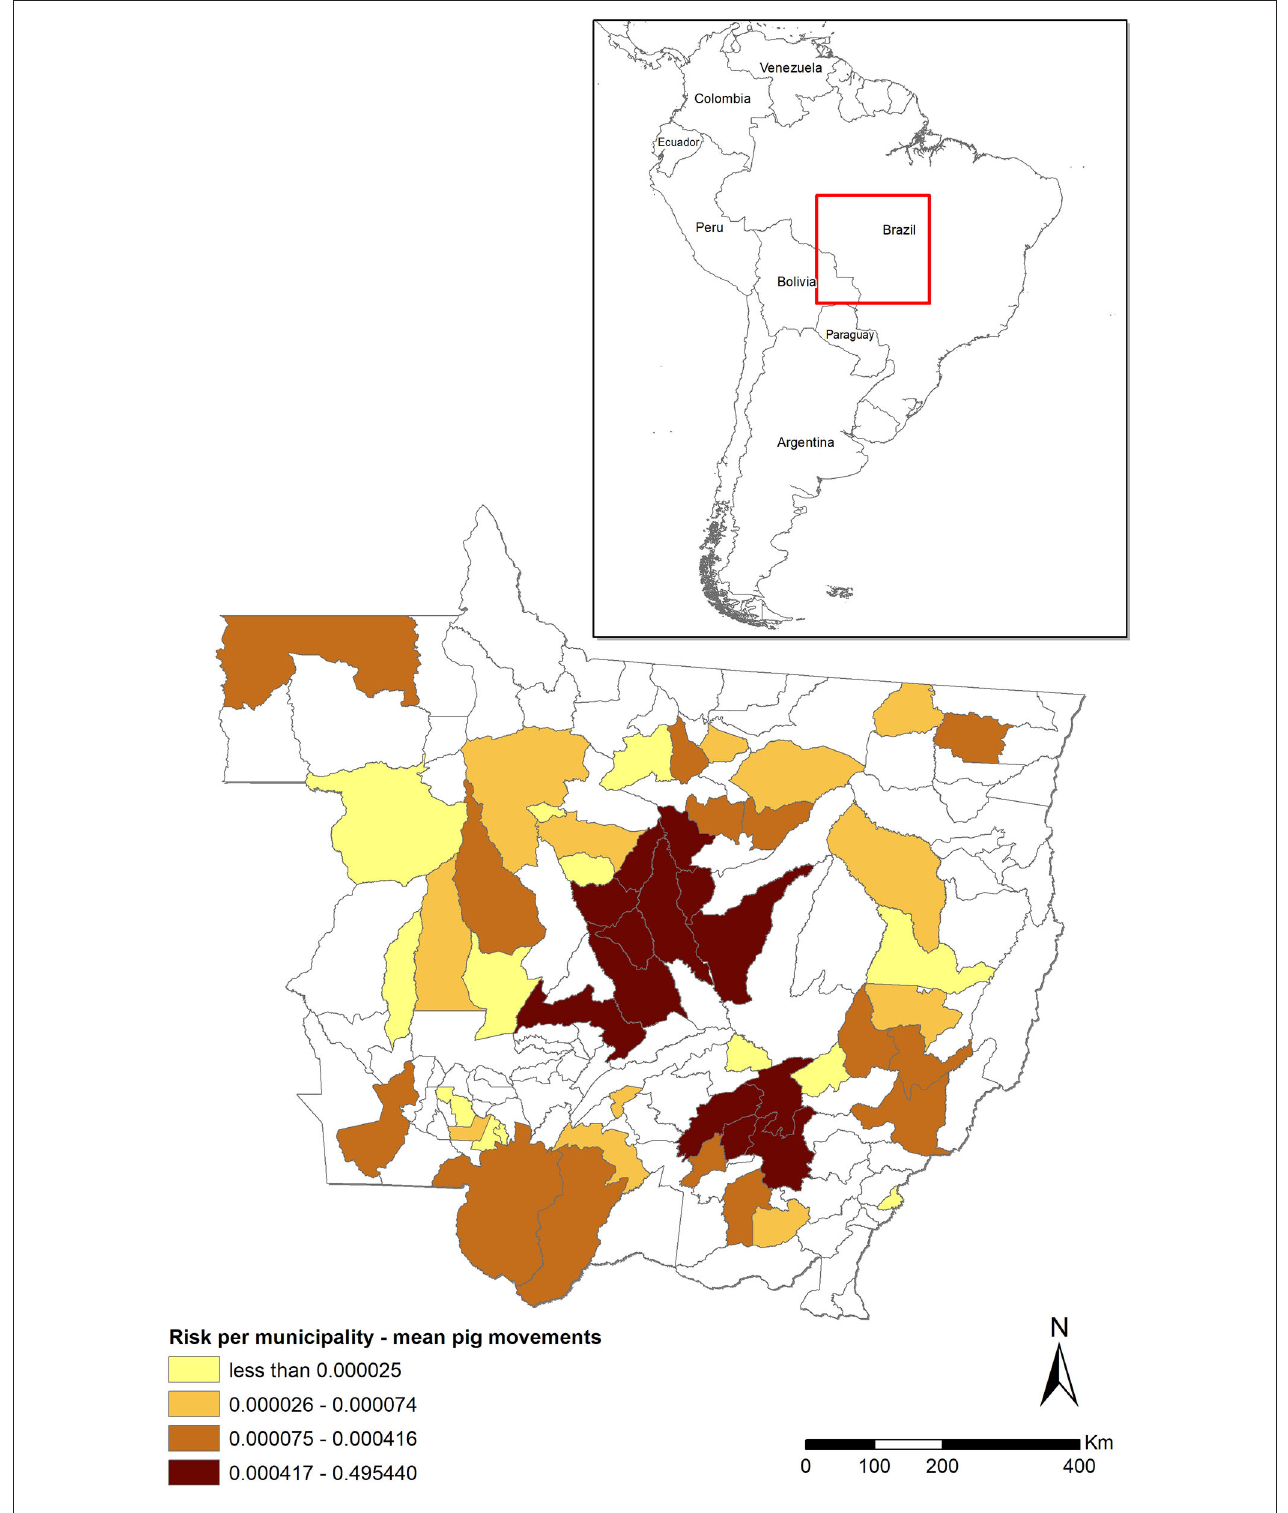
FIGURE 1 | Risk of classical swine fever (CSF) introduction into Mato Grosso (MT) through movement of pigs (Rpm) stratified by municipality and assuming an undetected outbreak in states in the CSF-free zone that ship pigs to MT. The darker the shade, the higher the risk. Municipalities in white did not receive pigs from outside MT during the assessed 3-year period. The red square shows the localization of MT in Brazil/Latin America map.